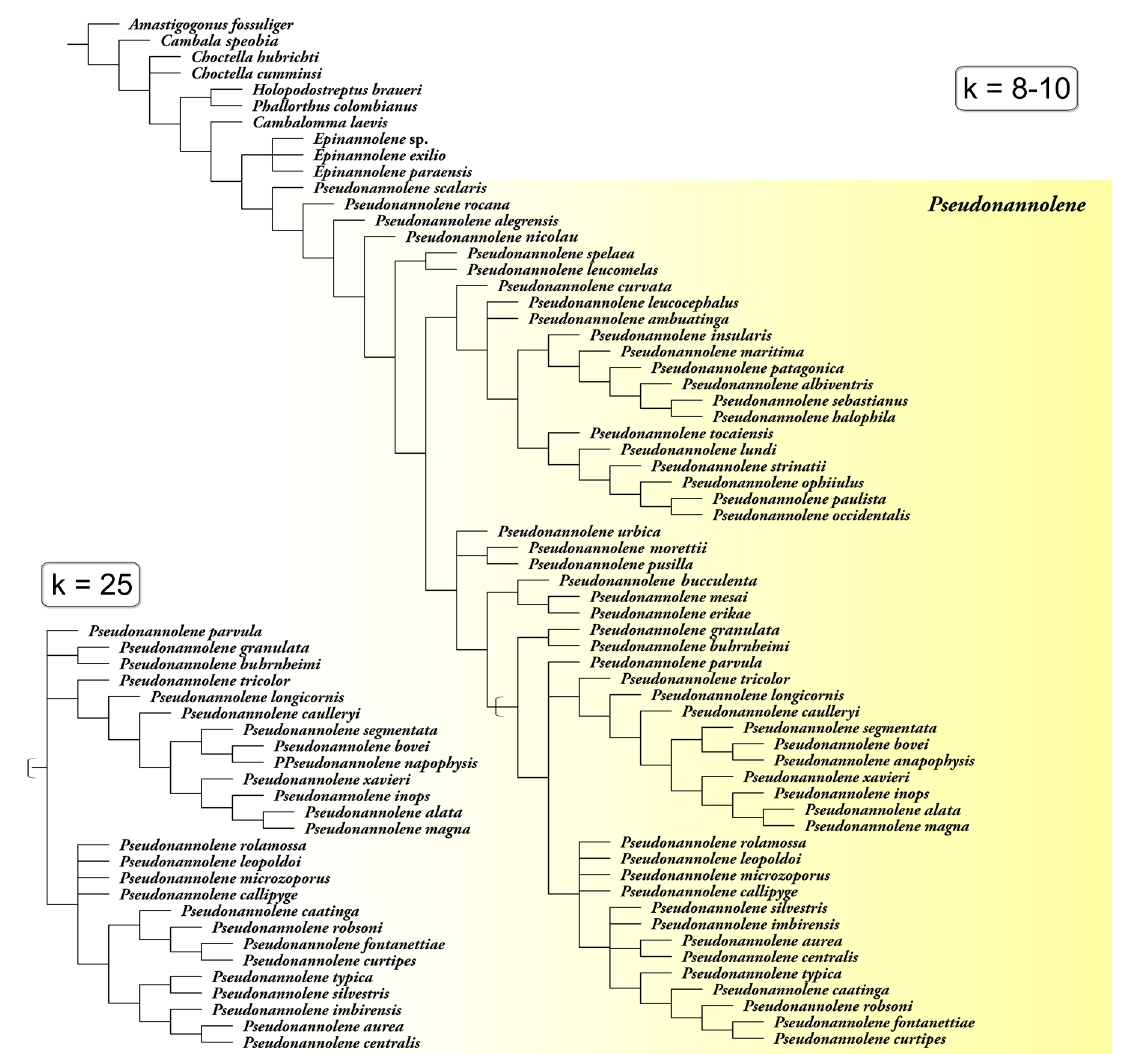
Fig. 7. Strict consensus of equally parsimonious trees under implied weighting ( k = 8–10 and